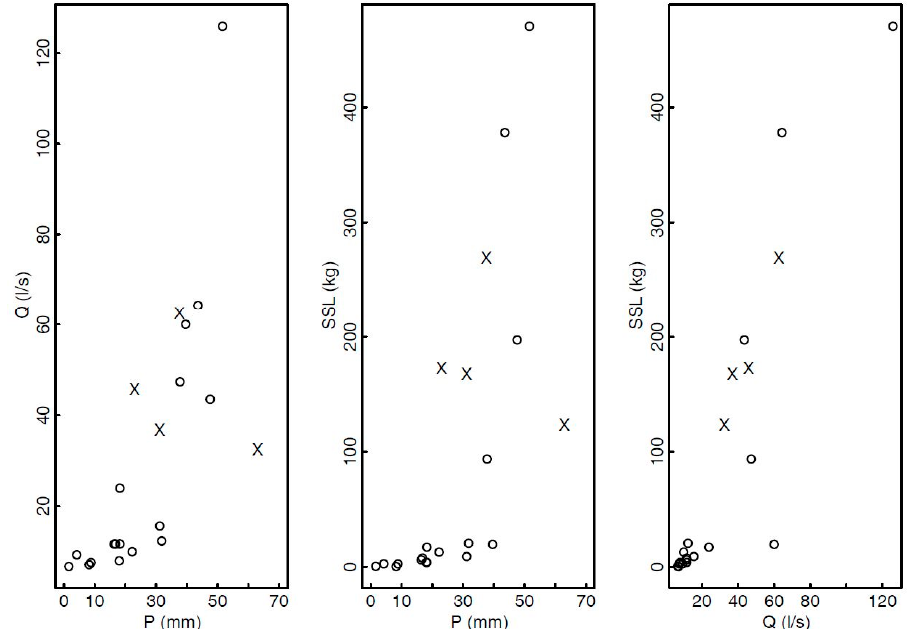
Figure 4. Graphical presentation of 21 events that were used to define the copula model for the Kuzlovec torrent. Crosses indicate multiple-peaks events and circles indicate single-peak events. Table 2. Summary statistics of the defined variables for the data from the Kuzlovec torrent.